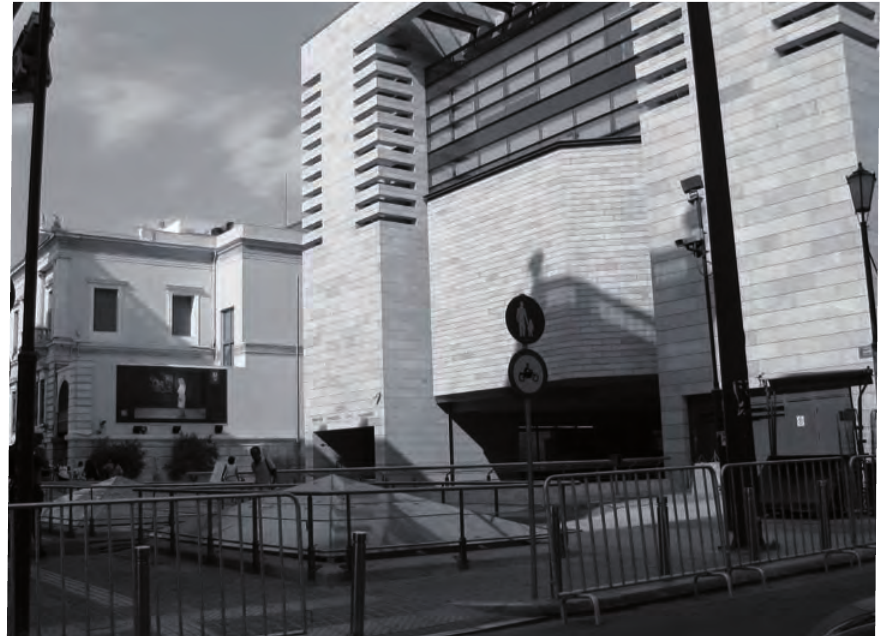
Figure 6. The remains of the “Archarnikai Gate” are preserved in a semi open air space in the basement of the National Bank of Greece, Athens. Remains opposite to the site are protected by pyramidoid shelters (Photo by K.